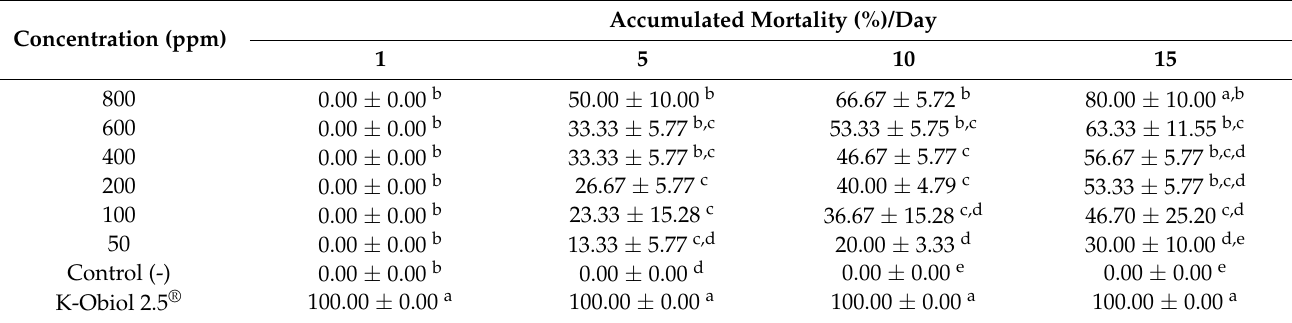
Table 4. Mortality (%) of the maize weevil Sitophilus zeamais treated with Schinus molle essential